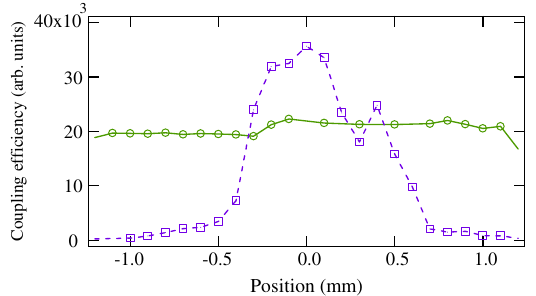
FIG. 9. Coupling efficiency vs position for the current optical setup (dashed line) and for the modified optical setup with diffuser and lens (solid line). Measurement performed in the lab using a pulsed laser as light source.